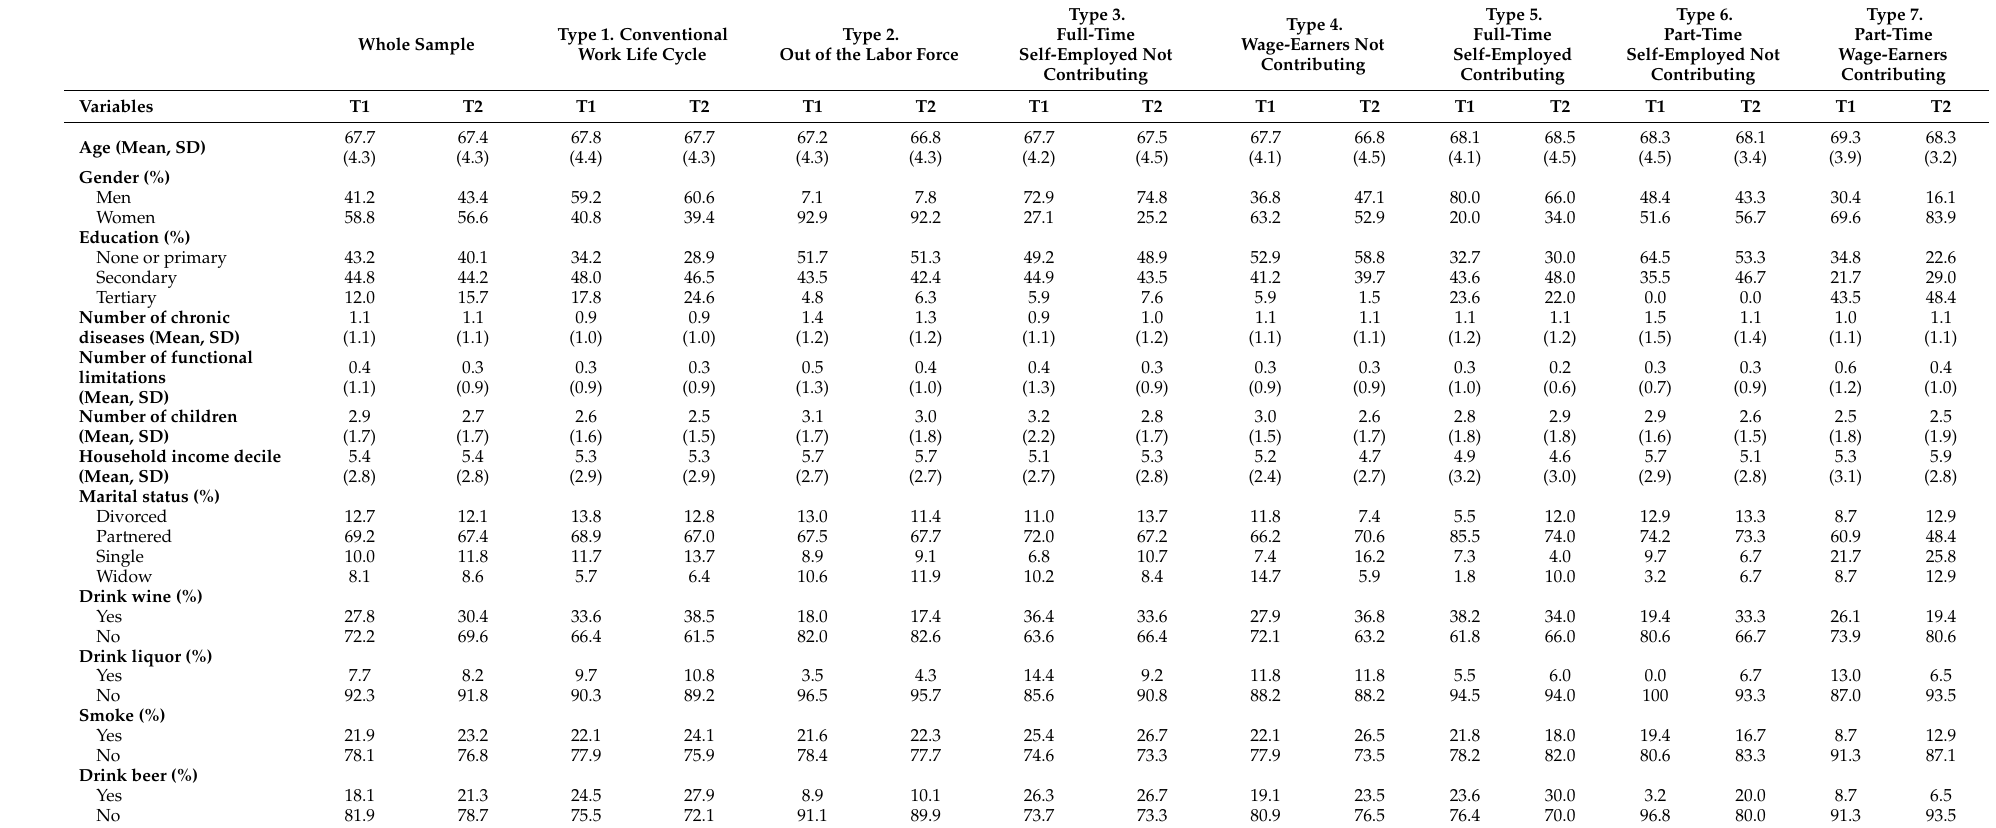
Table A1. Descriptive statistics of control variables for the whole sample and for each employment trajectory